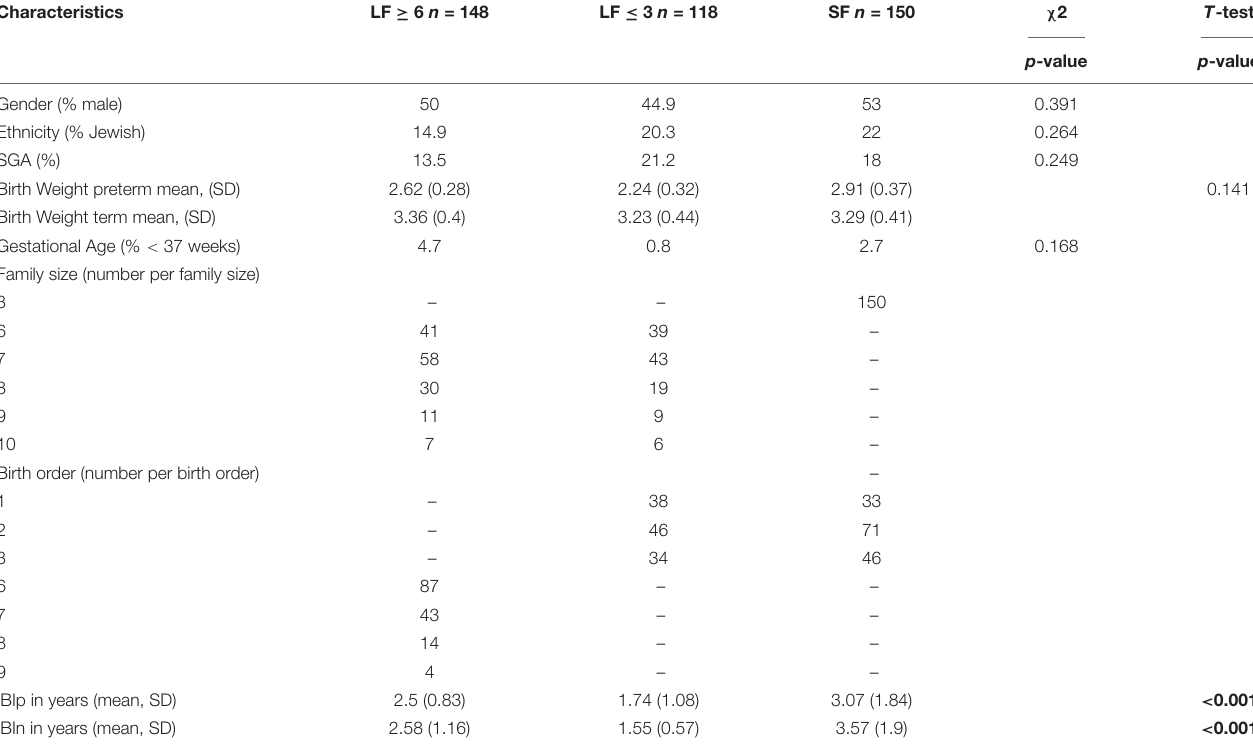
TABLE 1 | Baseline characteristics for all children included in the study and comparison of the main study variables between the study groups. Characteristics